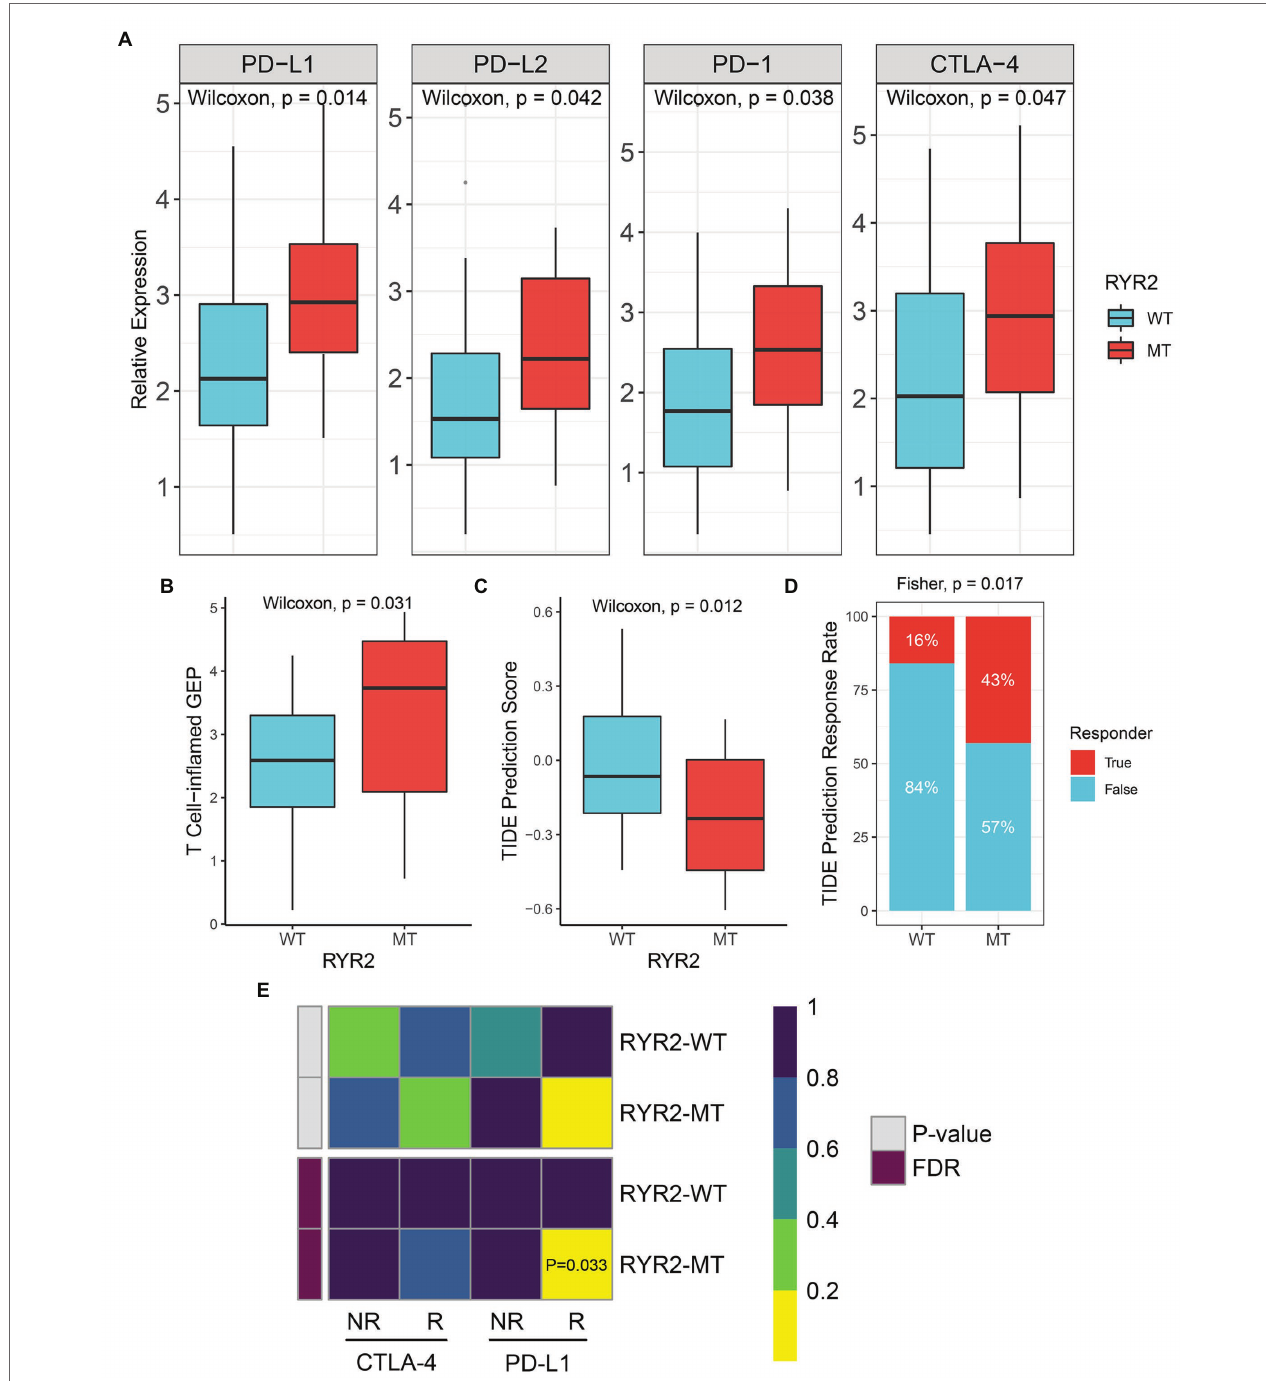
FIGURE 4 | RYR2 mutation suggested better immunotherapy response. (A) Expression distribution of PD-L1 , PD-L2 , PD-1 , and CTLA-4 between patients with and without RYR2 mutation. (B,C) Distribution of T cell-inflamed gene expression profile (B) and Tumor Immune Dysfunction and Exclusion (TIDE) prediction score (C) between patients with and without RYR2 mutation. (D) Distribution of immunotherapy responders predicted by TIDE algorithm between patients with and without RYR2 mutation. (E) SubMap algorithm evaluated the expression similarity between the two phenotypes and the patients with a different immunotherapy